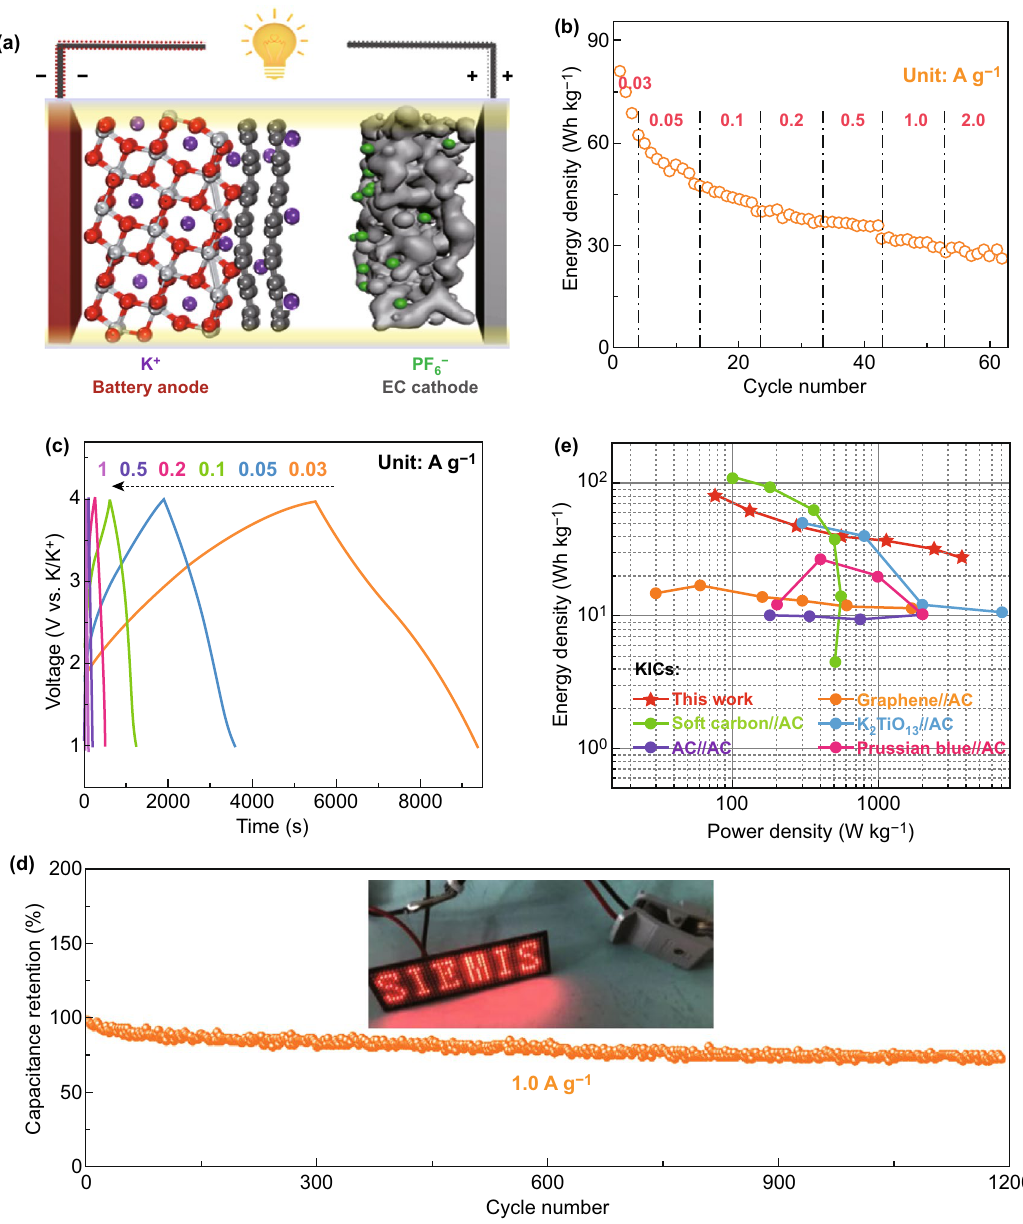
Fig. 5 Electrochemical performance of G‑TiO 2 NT‑derived KIC full cells. a Schematic illustration of G‑TiO 2 NTs//PAC KIC full cell. b Rate performance of KIC devices at current densities from 0.03 to 2.0 A g −1 . c Galvanostatic charge/discharge curves of the KIC at different cur‑ rent densities. d Capacitance retention of the KIC at 1 A g −1 after 1200 cycles. Inset: a photograph showing a “SIEMIS” LED pad powered by G‑TiO 2 NTs//PAC KIC. e Ragone plot of G‑TiO 2 NTs//PAC KIC in comparison with other reported KIC